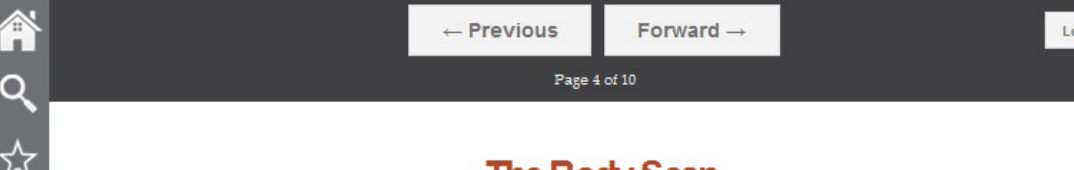
Figure 4. Video clips of MBCT group discussing the body scan and pertinent questions from community on this